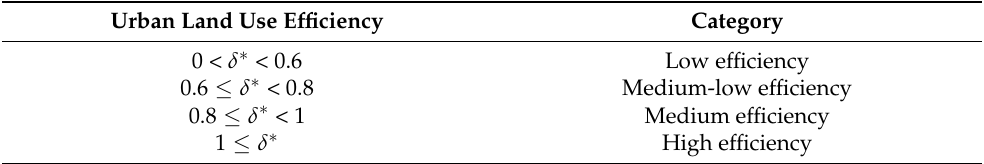
Table 3. Classification of urban land-use